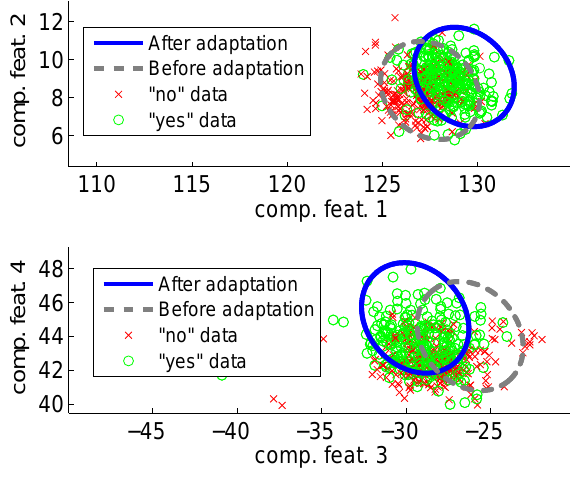
Figure 6. Class street/road features.